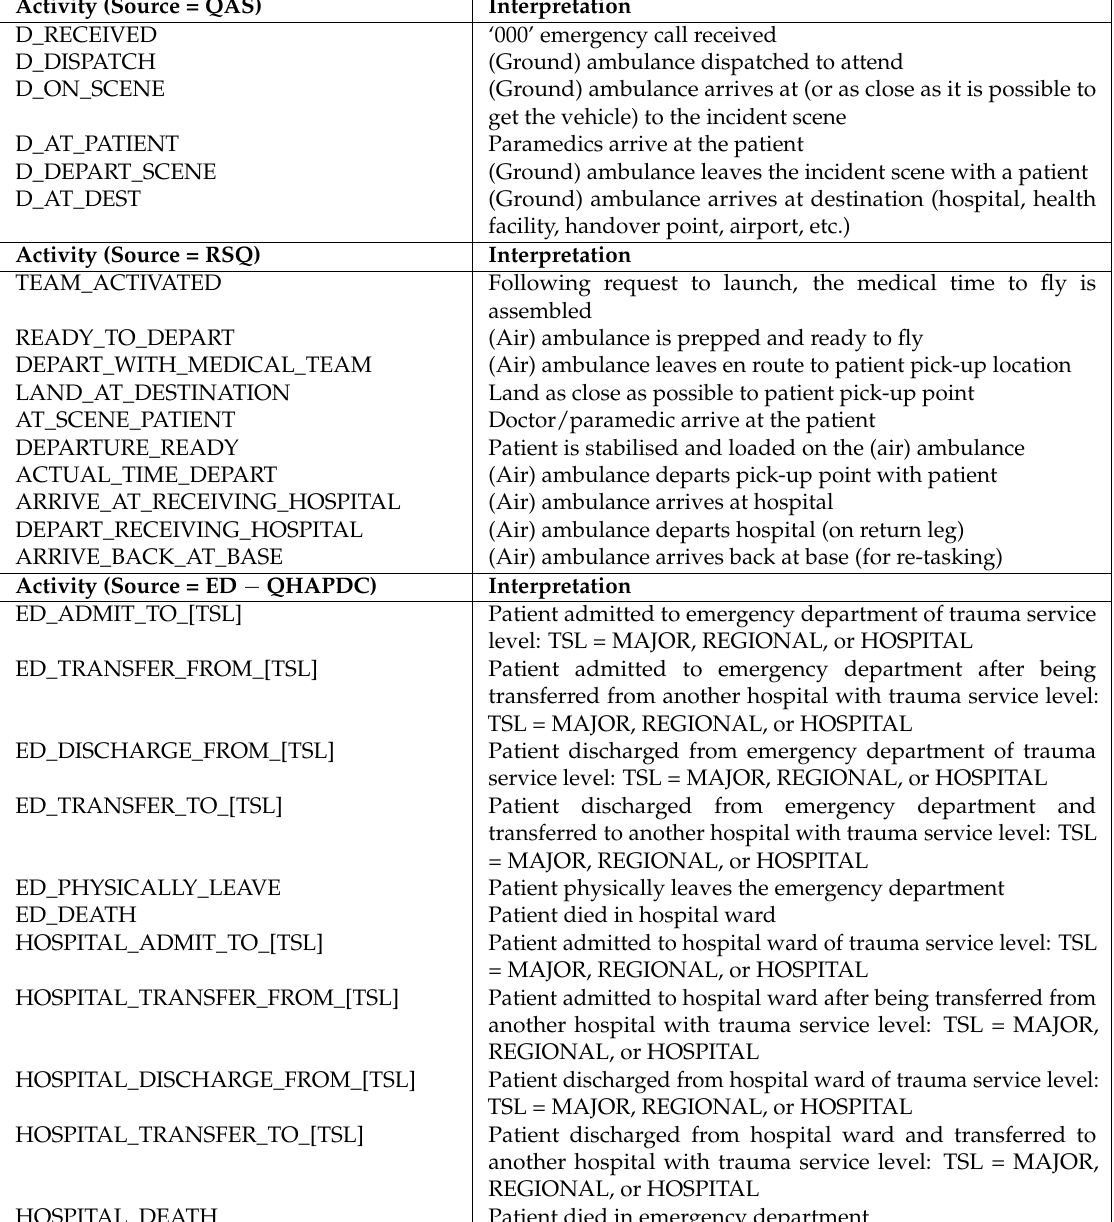
Table A1. Activity labels and